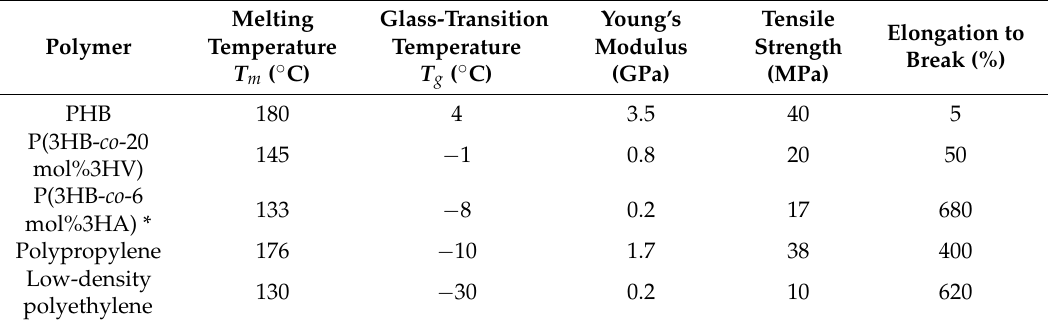
Table 2. Properties of PHB compared to PHBV and other PHAs